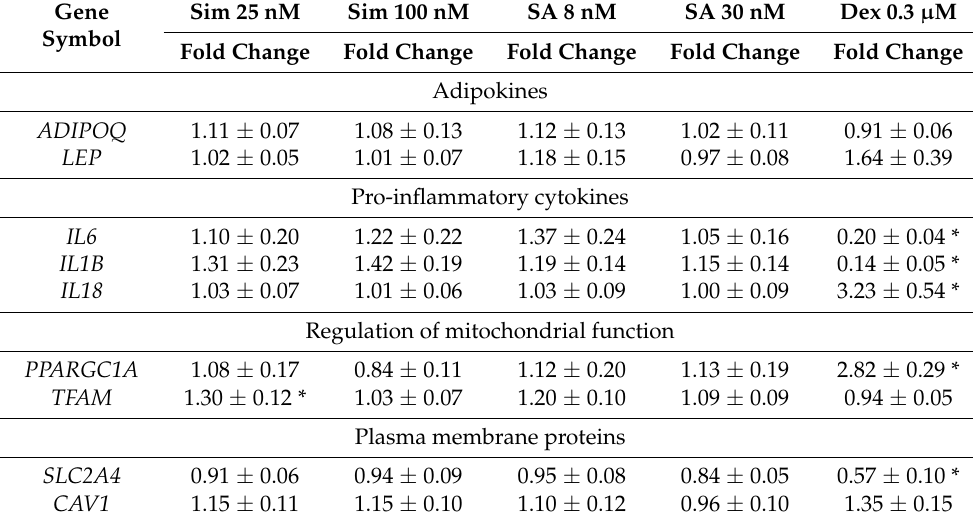
Table 5. Fold-change in gene expression in adipose tissue after 24 h incubation with simvastatin (Sim) and simvastatin acid